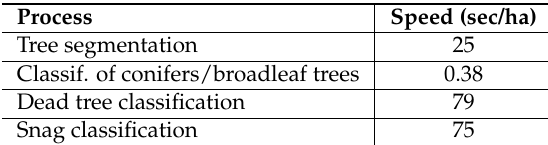
Table 19. Time performance of implemented